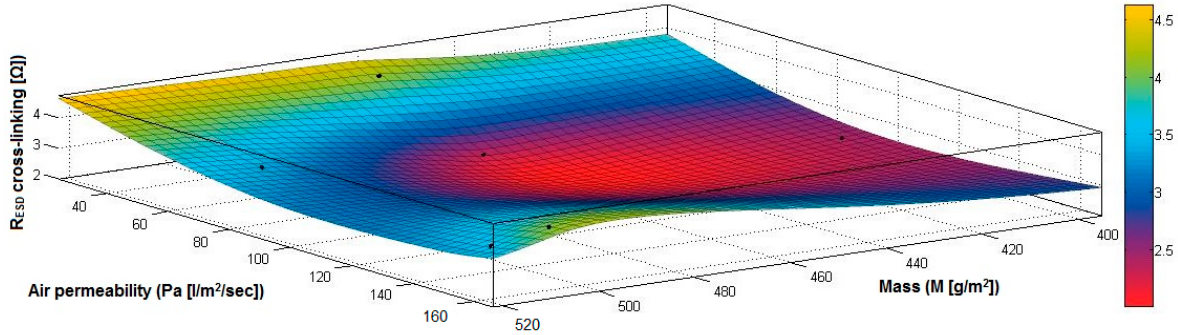
Figure 42. 3D representation R ESD after crosslinking = f(M, Pa) samples preliminarily treated in RF plasma O 2 using RF 2 generator and power 50 W.